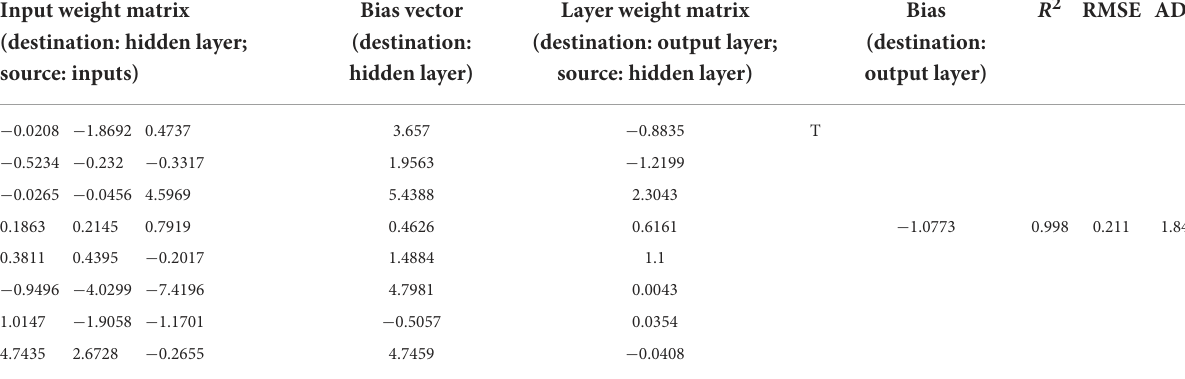
TABLE 1 Model-related parameters and fitting performance evaluation